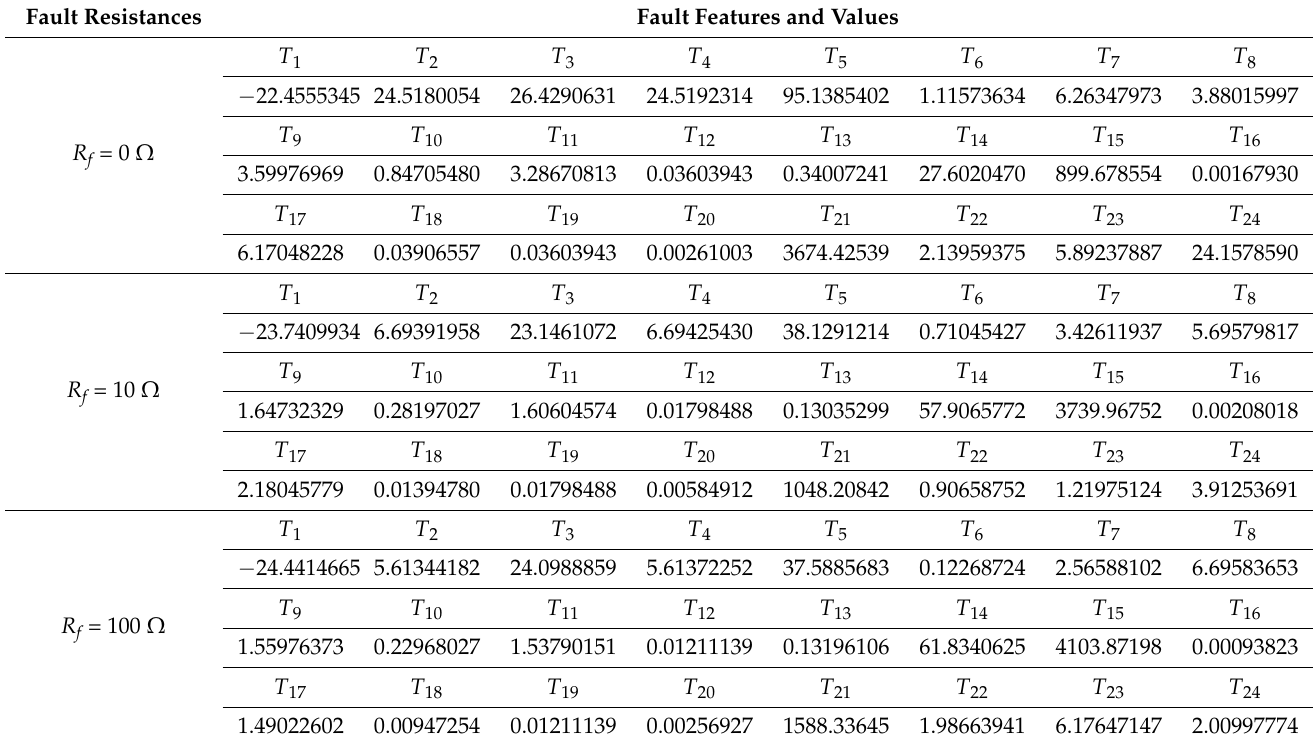
Table 5. Fault features and values with fault resistance.